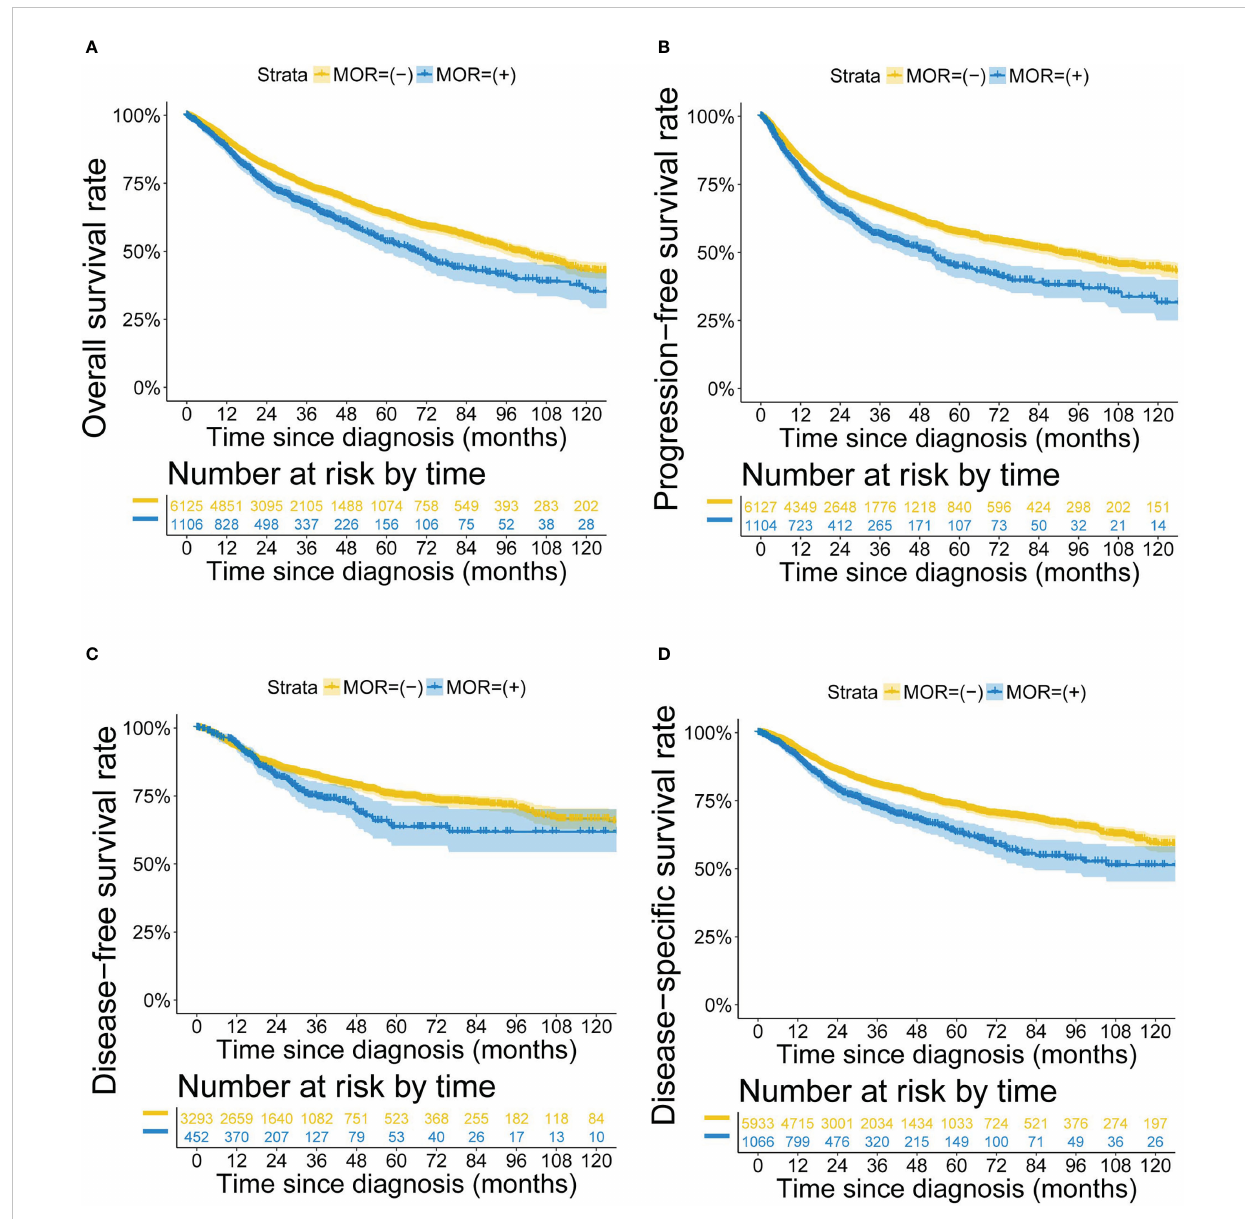
FIGURE 2 Kaplan-Meier survival curves according to MOR mRNA expression. Footnotes: Kaplan-Meier curves for (A) OS, (B) PFS, (C) DFS and (D)